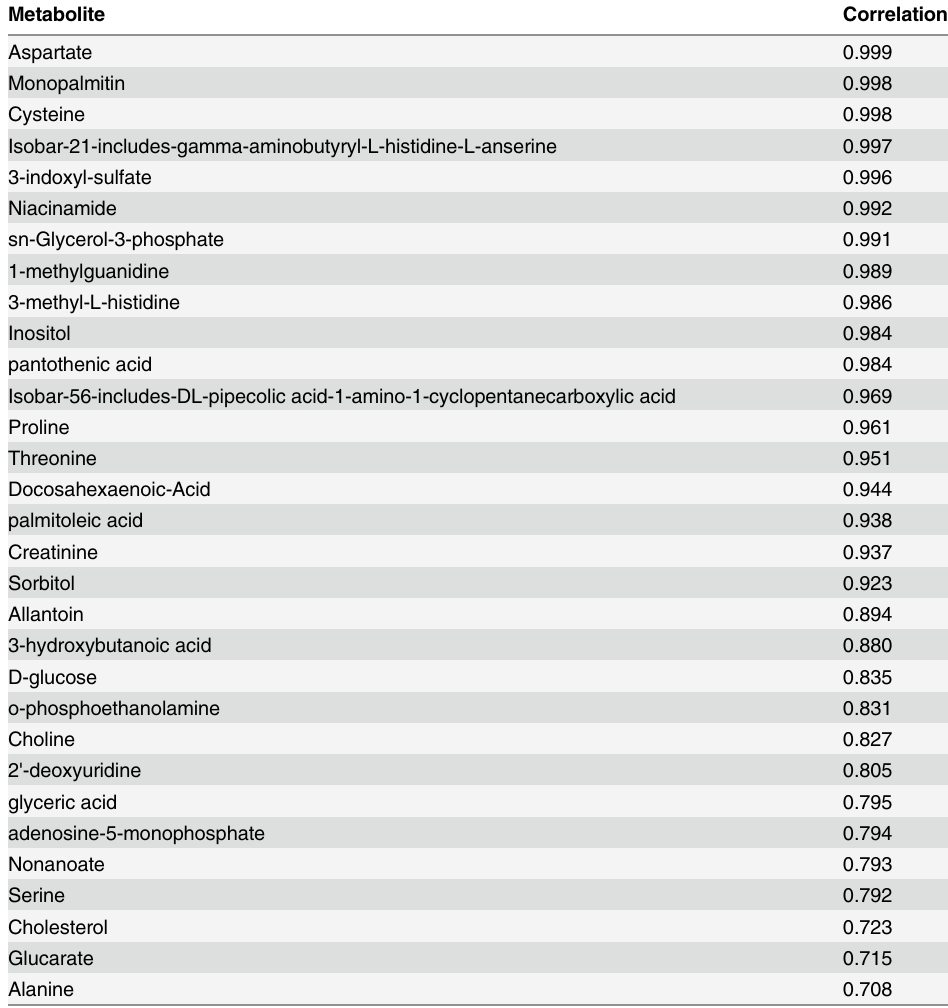
Table 1. Radiation dose dependent positive correlations between plasma and liver metabolites for whole liver irradiation for the combined radiation levels of 0, 10 or 50 Gy. Metabolite Correlation